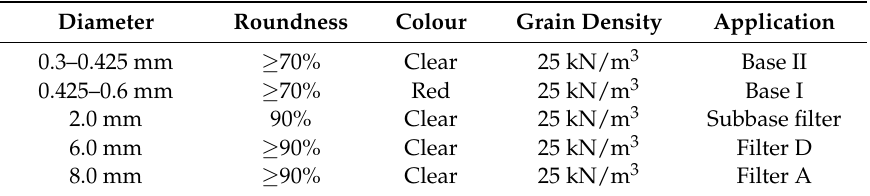
Table 2. Properties of the glass beads used in the experiments.